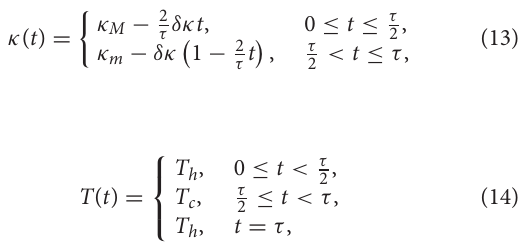
FIGURE 1 | (A) Schematic representation of a Stirling cycle of period τ performed by a colloidal heat engine, embedded in a viscoelastic fluid, by means of the 1 κ ( t ) x ( t ) 2 and of the bath temperature T ( t ). At time 0 temporal variation of the stiffness κ ( t ) of a trapping harmonic potential U ( x , t ) 2 = linearly decreased from κ M to κ m < κ M while keeping the temperature of the surroundings at high temperature T h (step 1 suddenly decreased to T c < T h (step 2 3), and kept at that value for τ/ 2 < t < τ , while linearly increasing the trap stiffness from κ m to κ M (step 3 → τ , at which the temperature is again increased to T h (step 4 completed at t 1). For a given realization of the cycle, the particle position x ( t ) encodes the = → information of the stochastic energy exchange between the particle and the surrounding fluid, as depicted by the noisy trajectory obtained by numerical simulations of x 2 Equation (8). (B) Schematic representation of the Brownian Stirling cycle in a - κ − 1 diagram, similar to the pressure-volume diagram of a h i